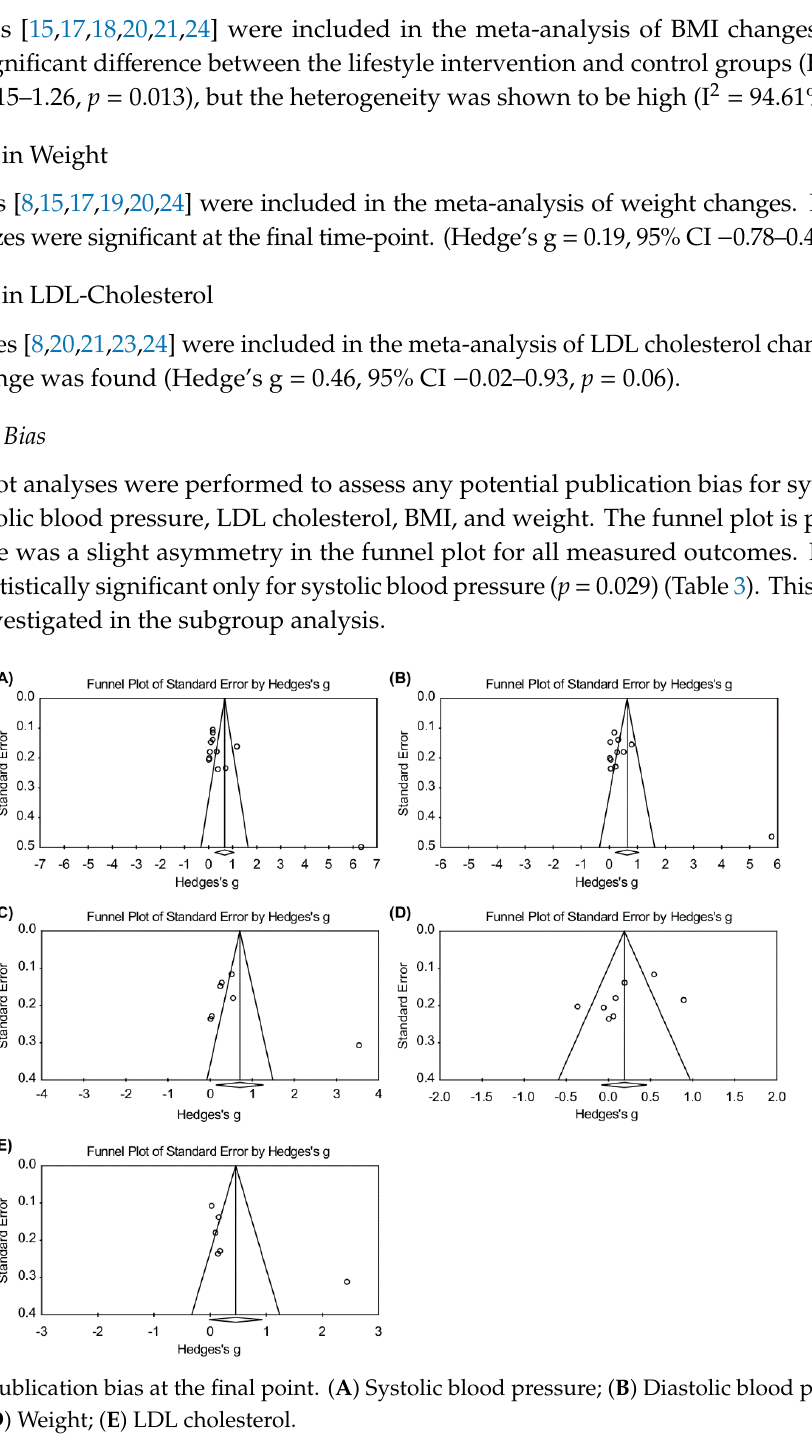
Figure 3. Publication bias at the final point. ( A ) Systolic blood pressure; ( B ) Diastolic blood pressure; ( C ) BMI; ( D ) Weight ； ( E ) LDL cholesterol. ( C ) BMI; ( D ) Weight; ( E ) LDL